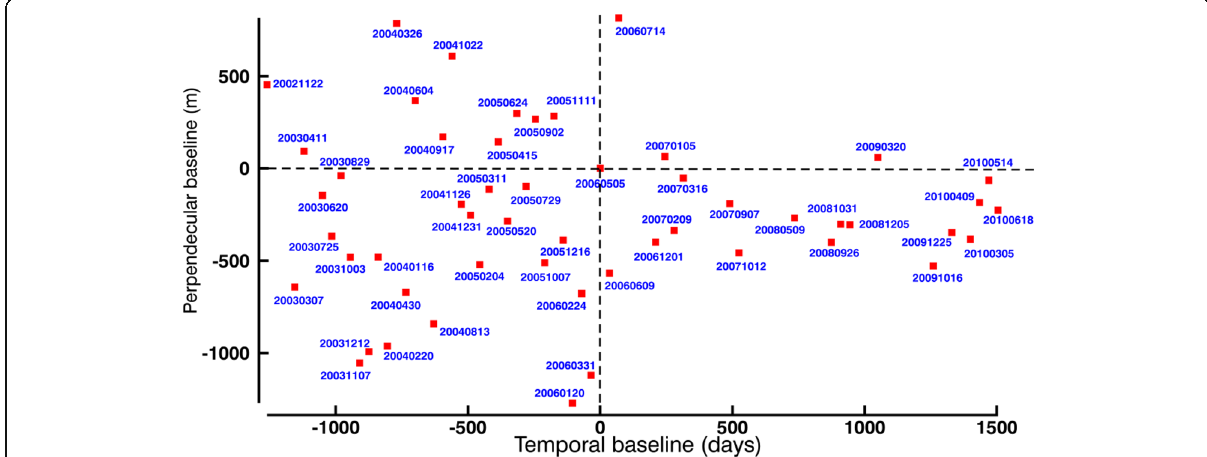
Fig. 5 ENVISAT-ASAR data sets